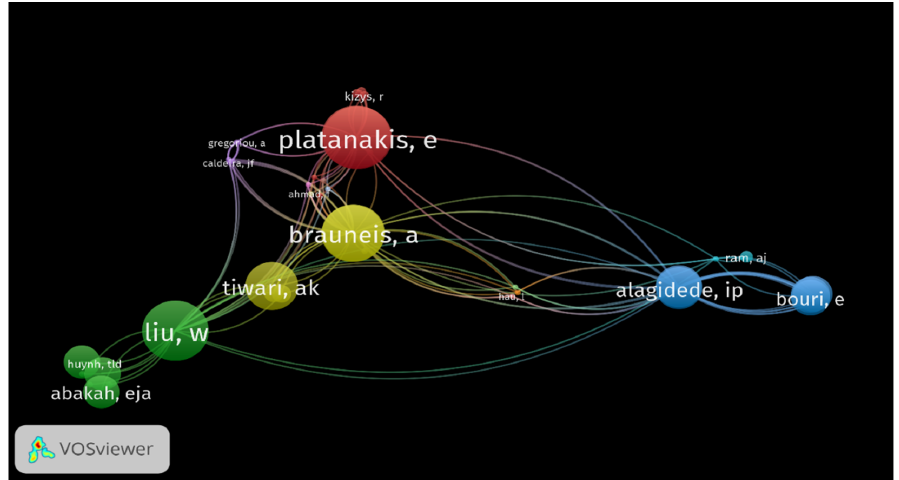
Figure 1. Citation analysis (units of analysis are authors). There are 8 clusters detected according to citation analysis, the total number of authors is less than 50.